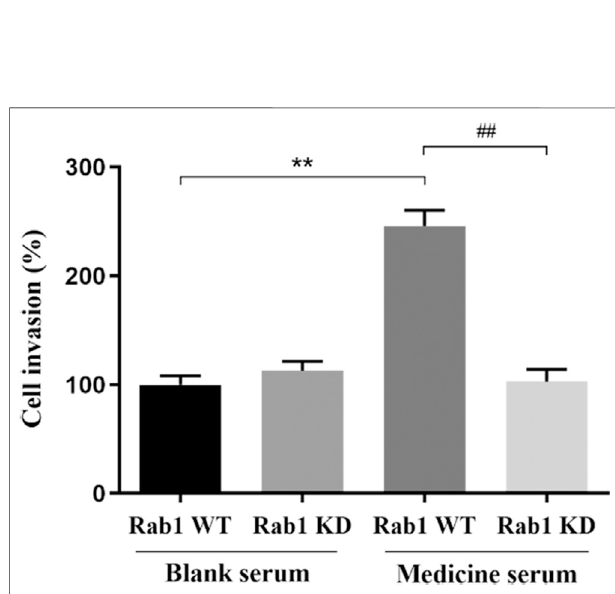
FIGURE11| TheeffectofFYXNserumonthemigrationofBMECs,** p < 0.01, compared withNC +Rab1WT group; ## p < 0.01, compared withFYXN + Rab1WT